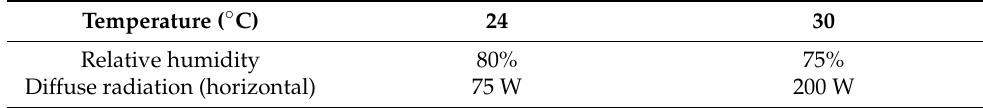
Table 2. Solar Radiation and Humidity at 24 °C and 30 °C. Table 2. Solar radiation and humidity at 24 ◦ C and 30 ◦ C.